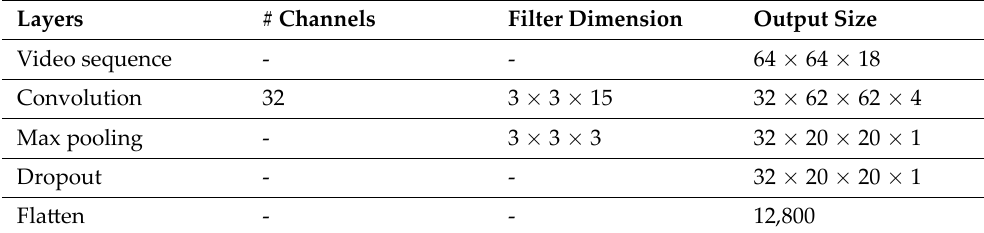
Figure 2. Structure of the proposed DS-3DCNN. Table 1. Network components of the video stream.